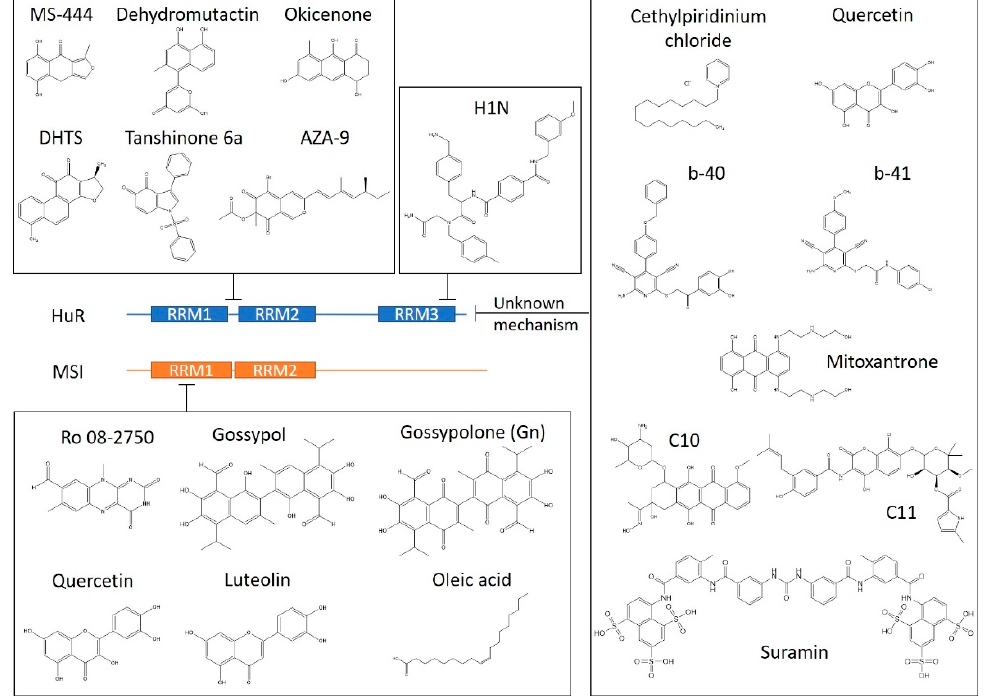
Figure 3. Regulation of HuR and Musashi proteins (MSI) binding to RNA. RNA recognition motifs (RRMs) of HuR are shown in blue, and RRMs of MSI are shown in orange. Small molecules interrupting RNA binding activities of HuR or MSI are displayed. The known targeting RRMs are indicated. HuR inhibitors with unknown mechanisms are shown.